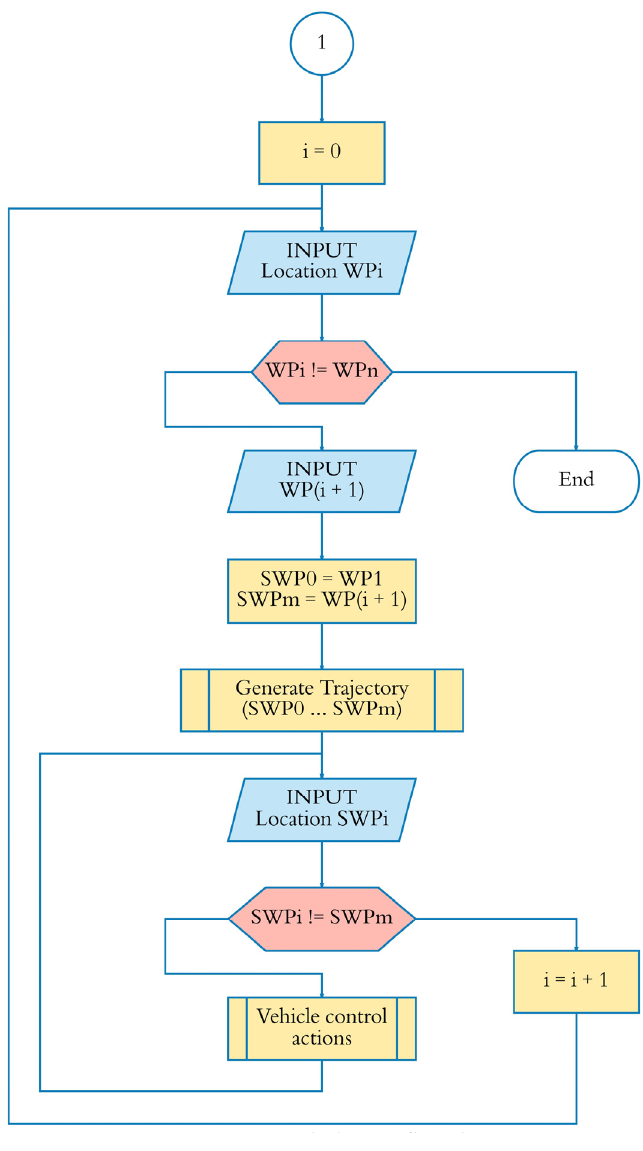
Figure 7. Local planner flowchart.